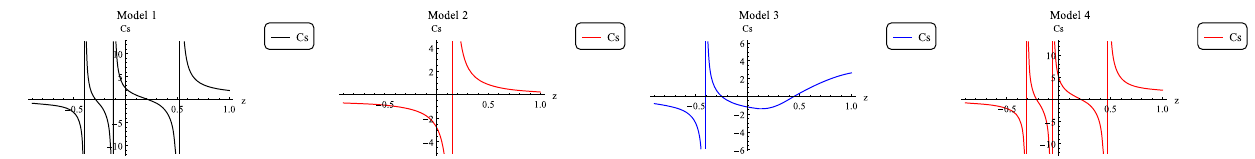
Fig. 10 The speed of sound Cs 2 in terms of red-shift under different viable